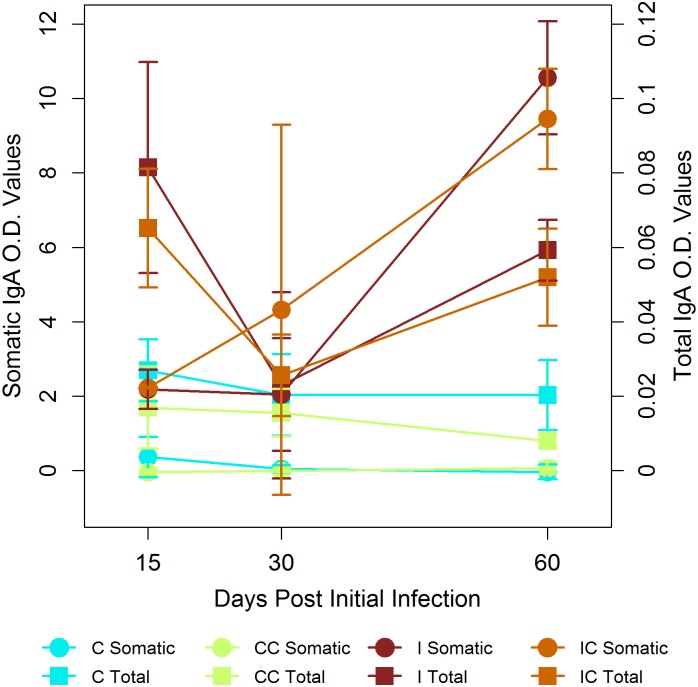
Antibody IgA from the duodenal mucus.Mean (±s.e.) Optical Density (O.D.) for the species-specific (left y-axis, full cycle) and the total (right y-axis, full square) IgA by treatment (Infect: I, Infect+Collar: IC, Control+Collar: CC and Control: C) and sampling time (days post initial infection). Both specific and total IgA are higher in I and IC than in CC or C.